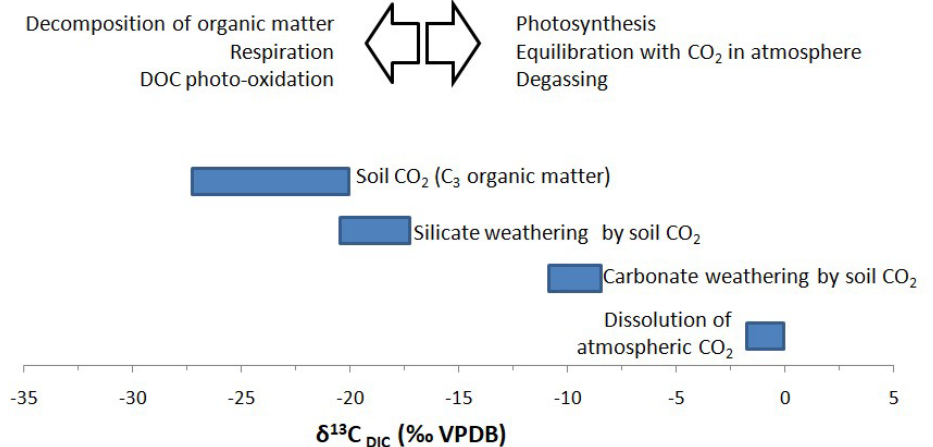
Figure 2. Schematic diagram showing the typical range of δ 13 C of different sources of dissolved inorganic carbon (DIC) in rivers. Various major processes influencing the δ 13 C of DIC ( δ 13 C DIC ) within the rivers were also shown. Black arrows indicate the direction of change in δ 13 C DIC due to the influences of different in-stream process, mentioned next to the